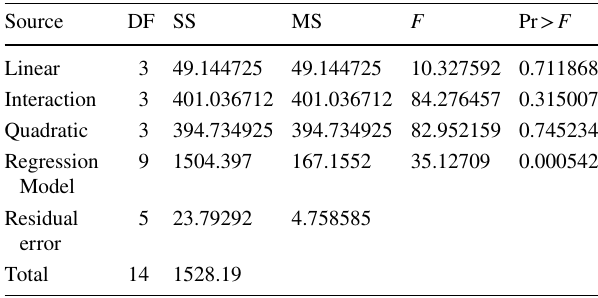
* R 2 99%; Adj R 2 96%; DF Degrees of freedom ; SS Sum of squares ; MS Mean square ; F F statistic (